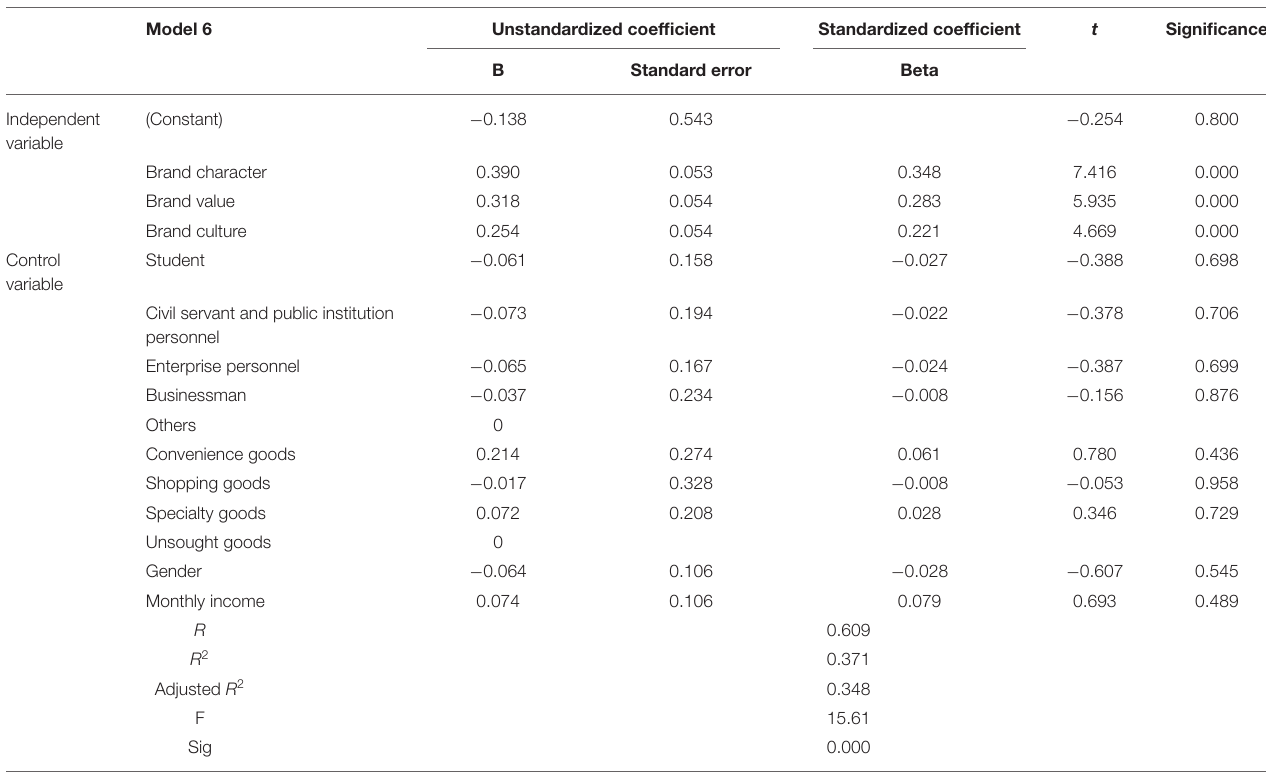
TABLE 7 | Regression analysis of each dimension of brand elements to social